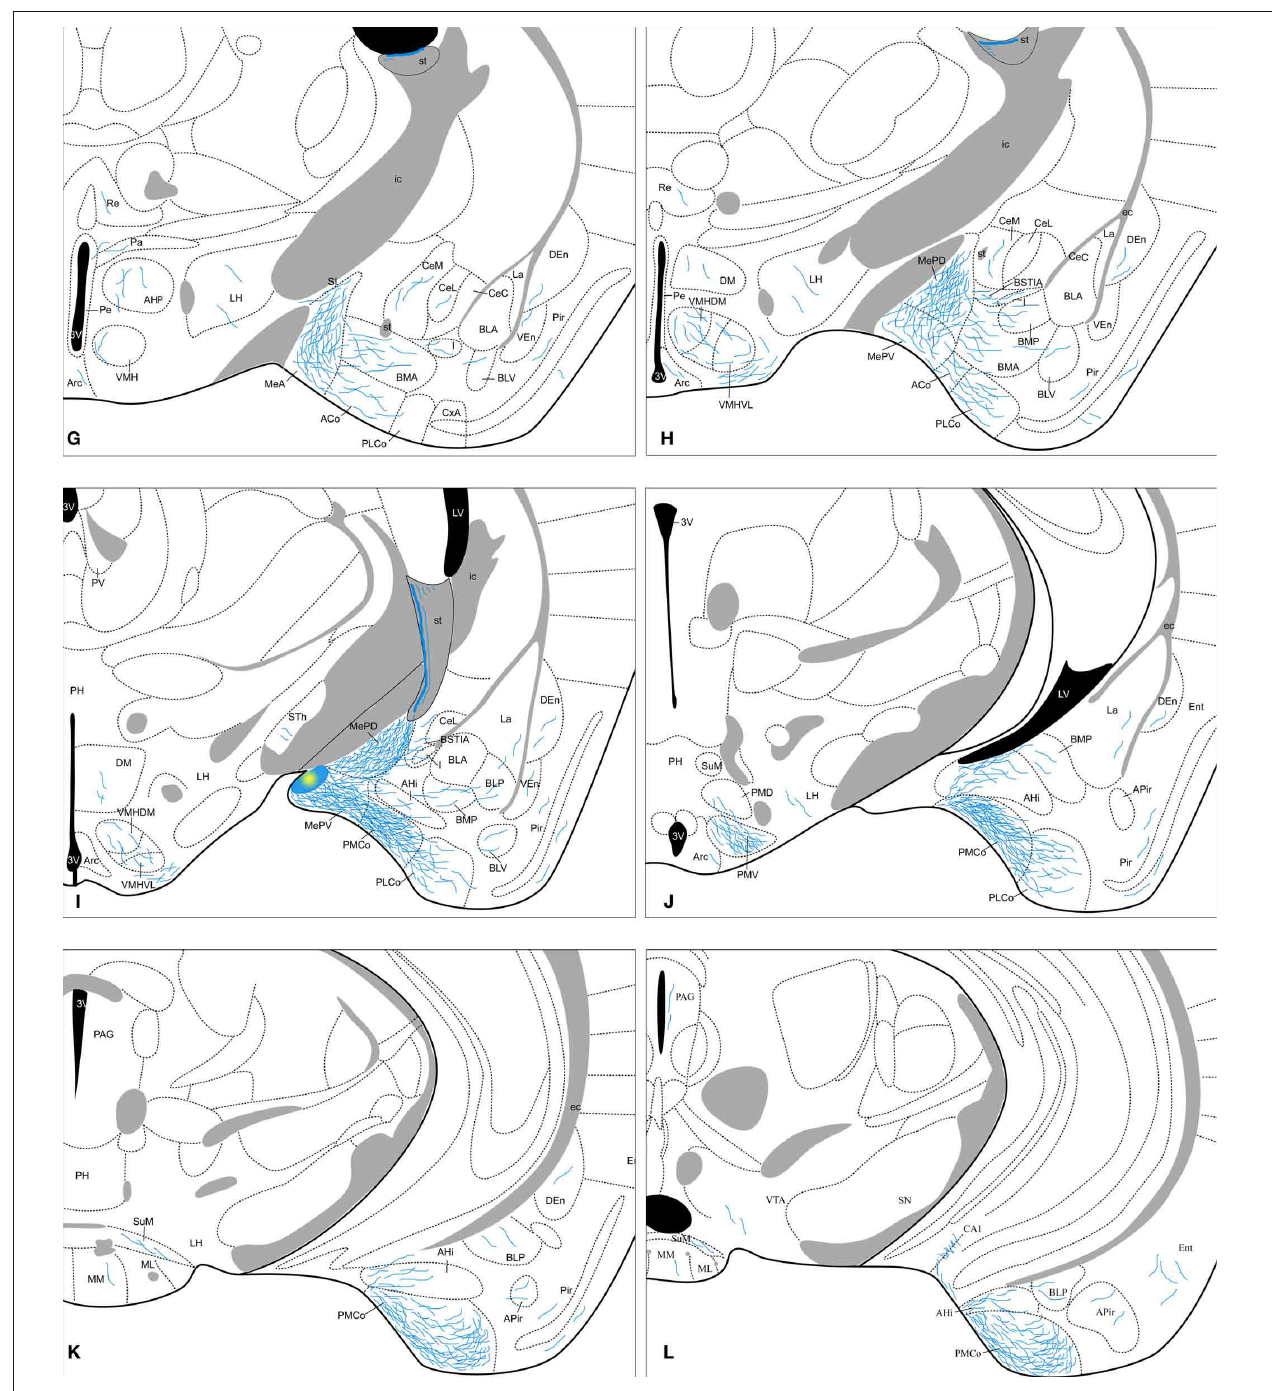
FIGURE 8 | Semi-schematic drawings of transverse sections through the mouse brain showing the distribution of anterogradely labeled fibers following tracer injections in the MePV. The injection site is depicted in